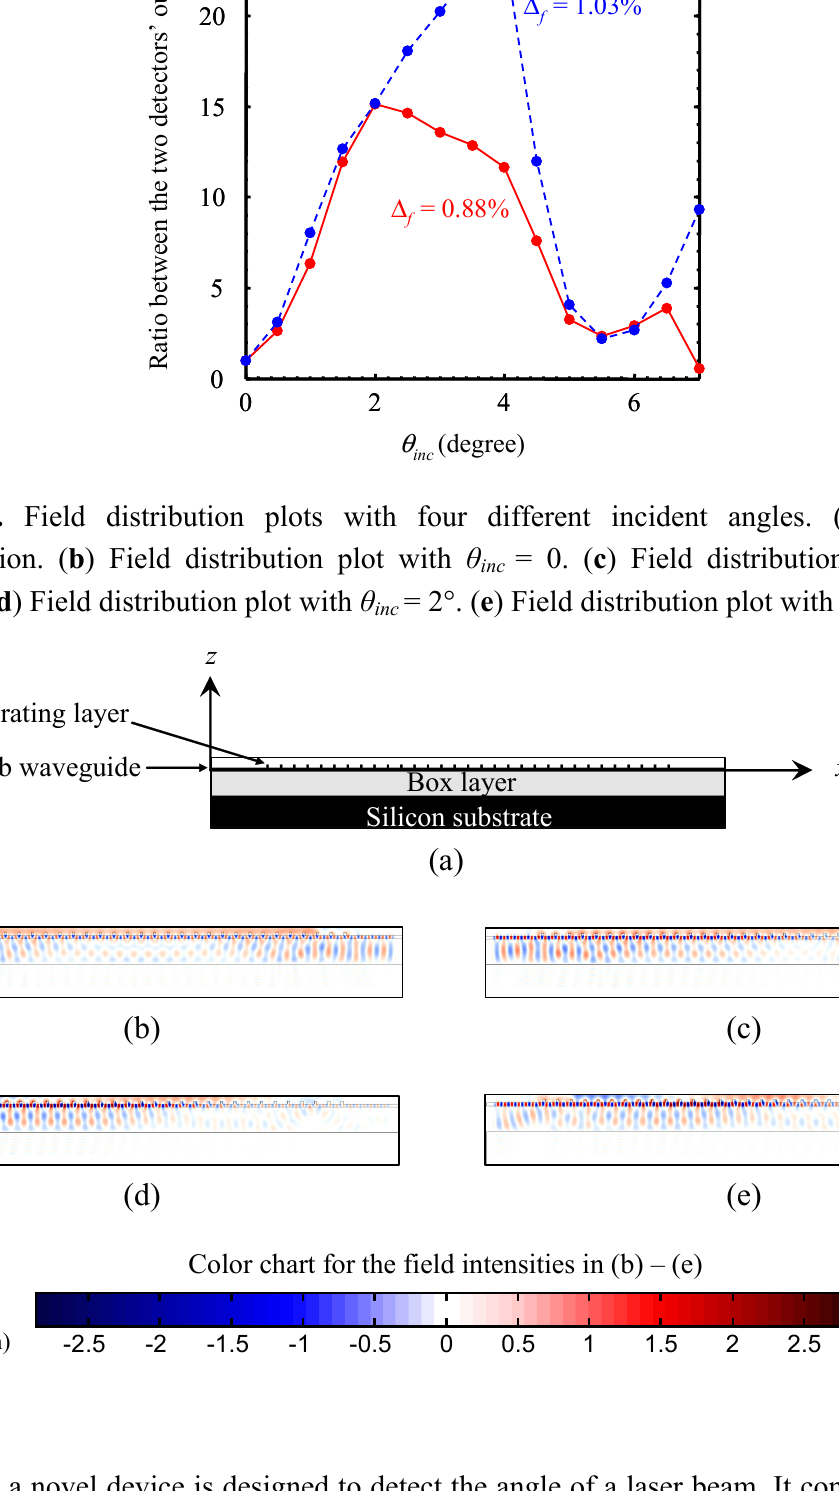
Figure 5. Numerical results for the angle detector with two different values of ∆